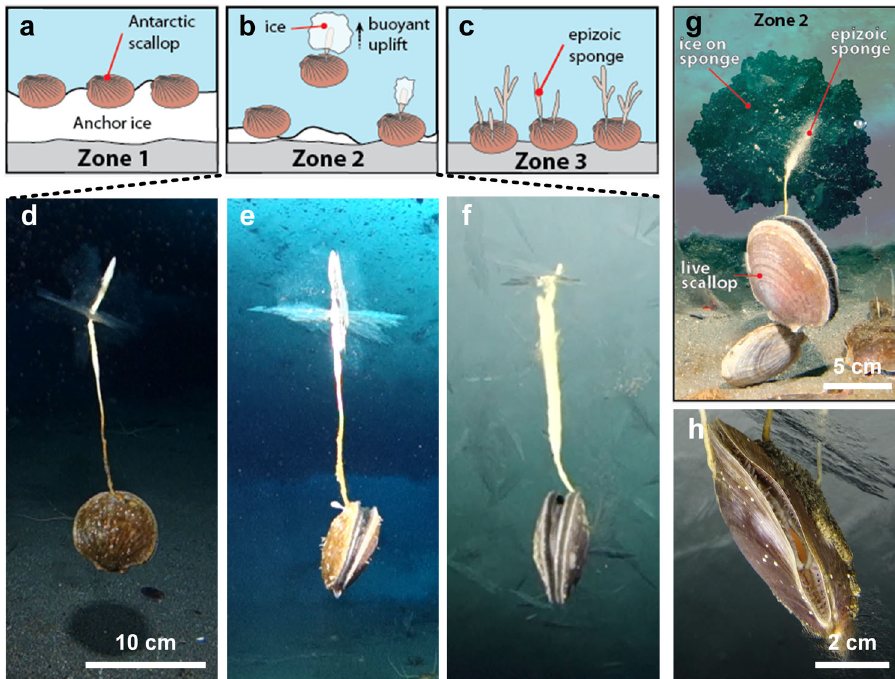
Fig. 2 Sea sponge-colonized Antarctic scallops demonstrate the potential dangers for organisms that do not avoid cryofouling. a – c Unless colonized by the cryofouling-susceptible bush sponge ( H. balfourensis ), Antarctic scallops appear to be unaffected by cryofouling, even in areas where underwater ice growth is prevalent (Zones 1 and 2). d – h Photographic images depicting the progression of cryofouling-induced uplift (by buoyant ice) of sponge-colonized scallops in Zone 2. The negative consequence of cryofouling for scallops becomes apparent only when its surfaces have been colonized by the bush sponge H. balfourensis , which readily accrete ice. g When a suf fi cient volume of ice has accreted on the sponge, both species are rafted to the underside of the sea ice by buoyant fl otation, where both appear to freeze in and die. Scallop is freezing into the underside of the sea ice. Scallop shell exteriors appear to be free of icing even after arriving at the underside of the sea ice. Note: Scallops arriving and freezing into the underside of the sea ice will eventually be enveloped by further sea ice growth. Scale bars indicated are approximates.